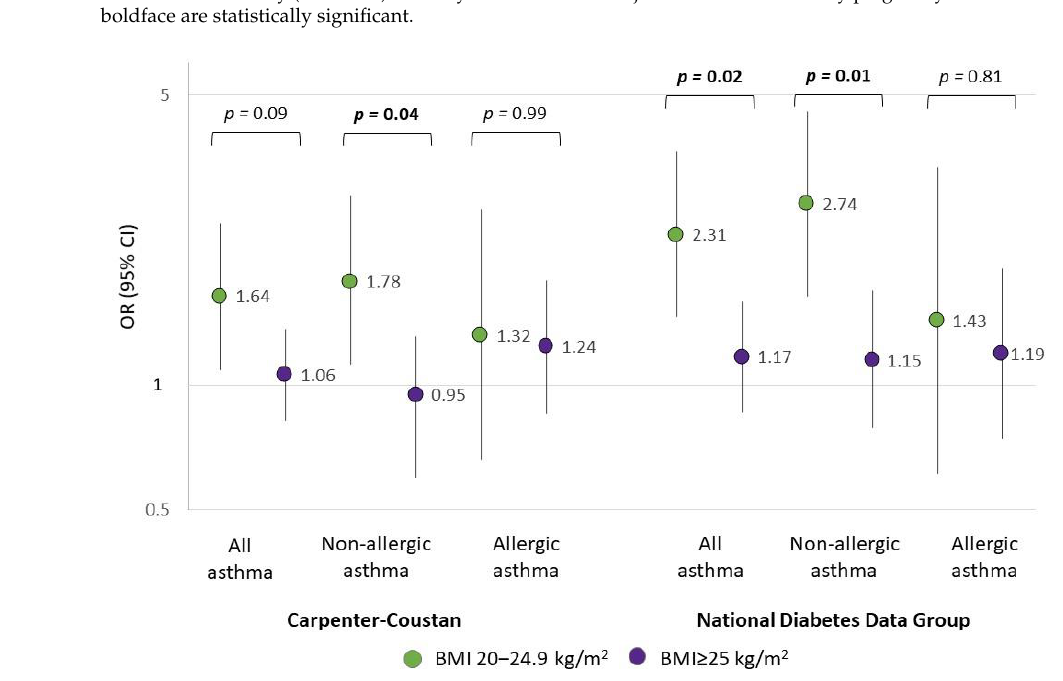
Figure 1. Associations of GDM with incidence of allergic and non-allergic asthma in childhood according to maternal early pregnancy BMI. BMI—body mass index; GDM—gestational diabetes mellitus; OR—odds ratio; CI—confidence interval. Analyses were adjusted for age at delivery, asthma, maternal race/ethnicity, smoking status, insurance status at birth, and mode of delivery (C-section). p-values for interaction are displayed on the upper part of the figure.